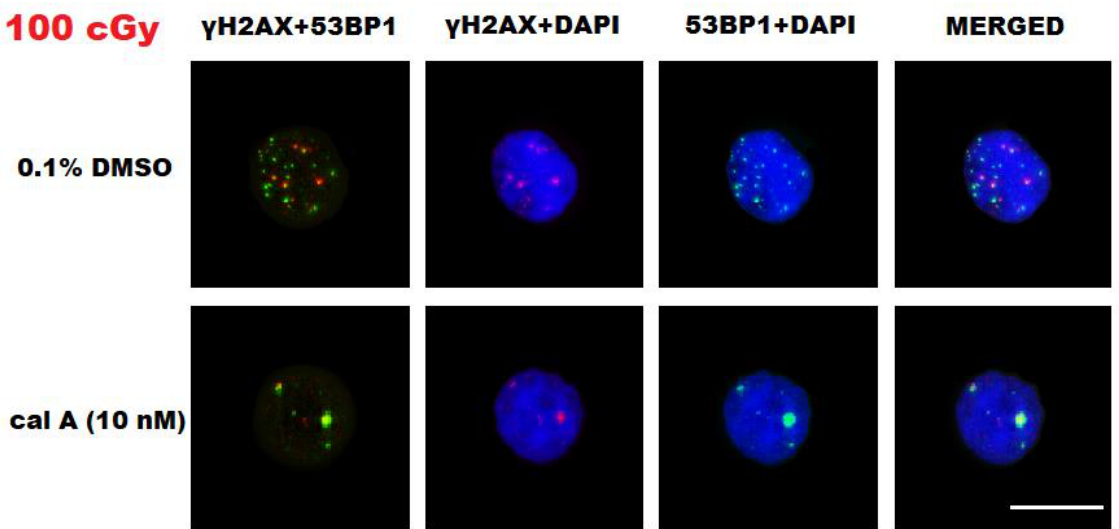
Figure 3. Representative images of DNA repair foci in human umbilical cord blood lymphocytes (UCBL) irradiated with 100 cGy and fixed 2 h after 0.1% DMSO and cal A (10 nM) treatments. Two middle columns represent nuclei (DAPI, blue channel) with γH2AX foci (red channel) and 53BP1 foci (green channel). All three channels (blue, red, and green) are merged in the very right column, while the very left one shows merged red and green channels. White bar equals 10 µm.